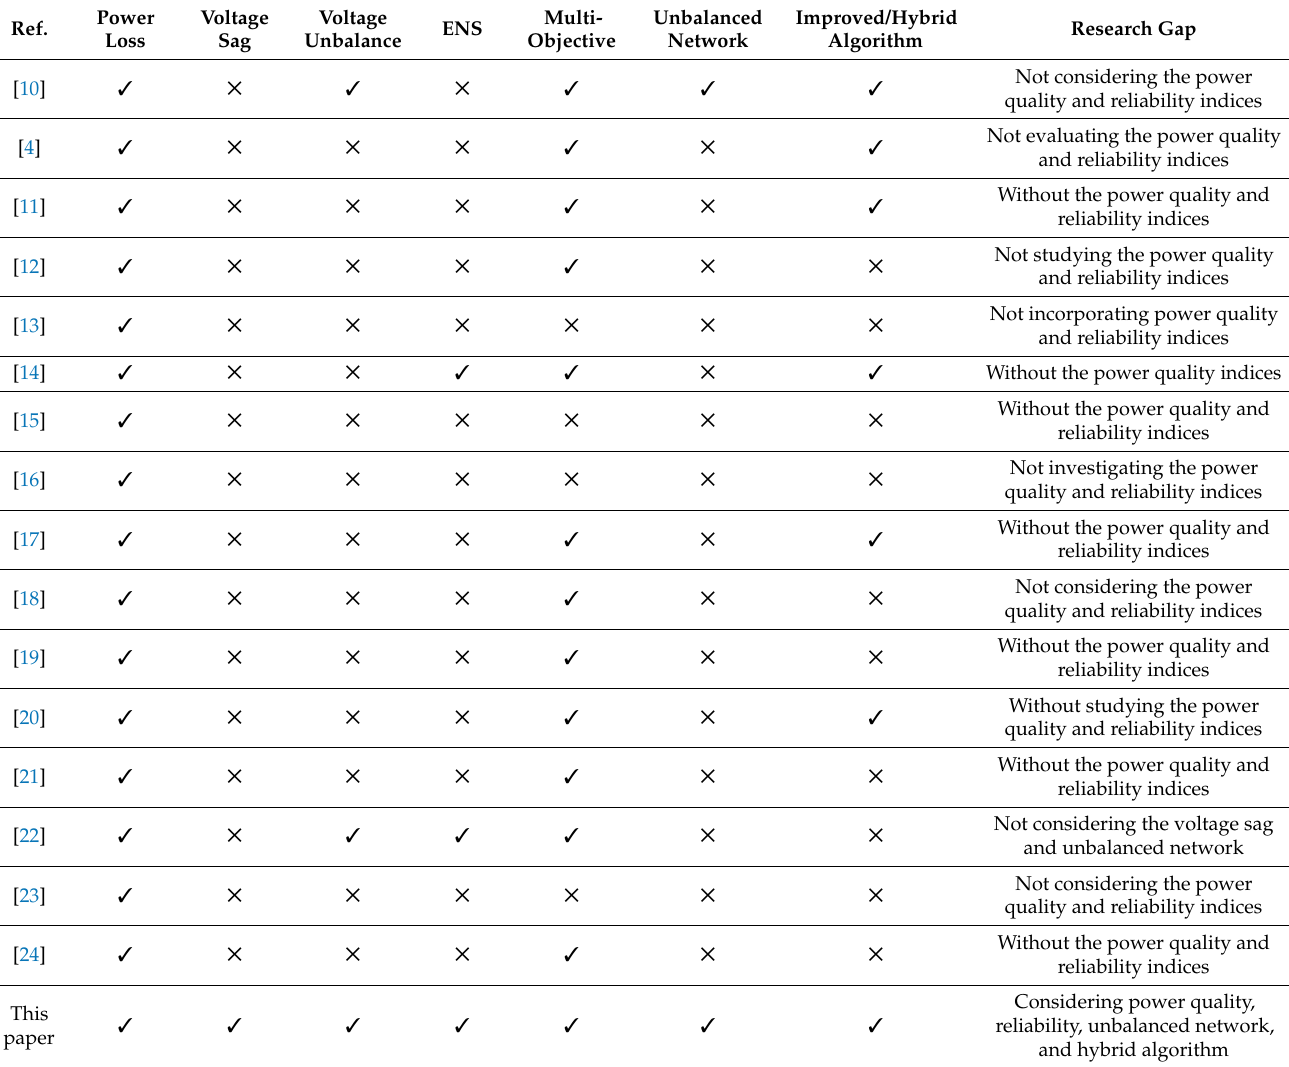
Table 1. Summary of previous studies on reconfiguration.